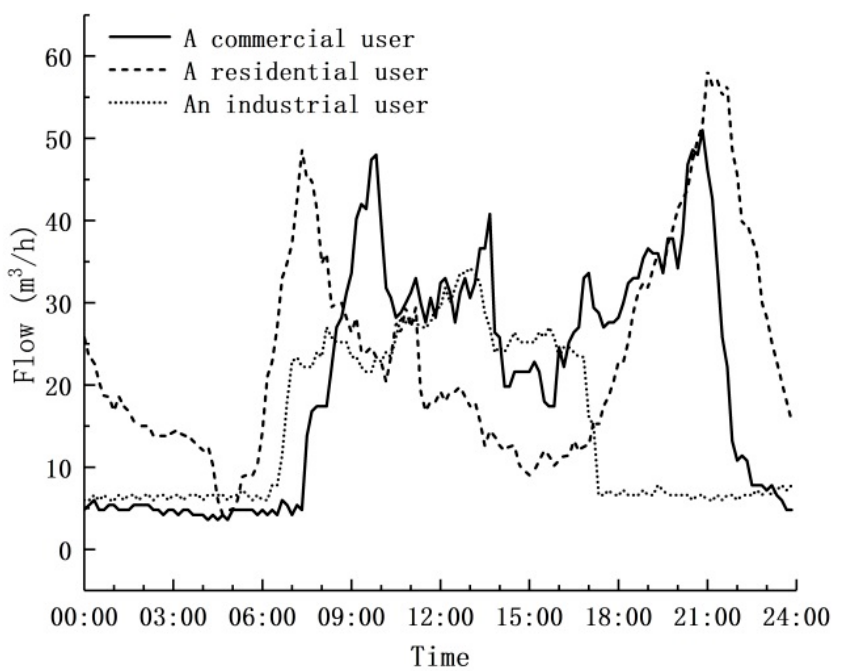
Figure 2. Ten-minute accuracy water consumption curves for three types of users.